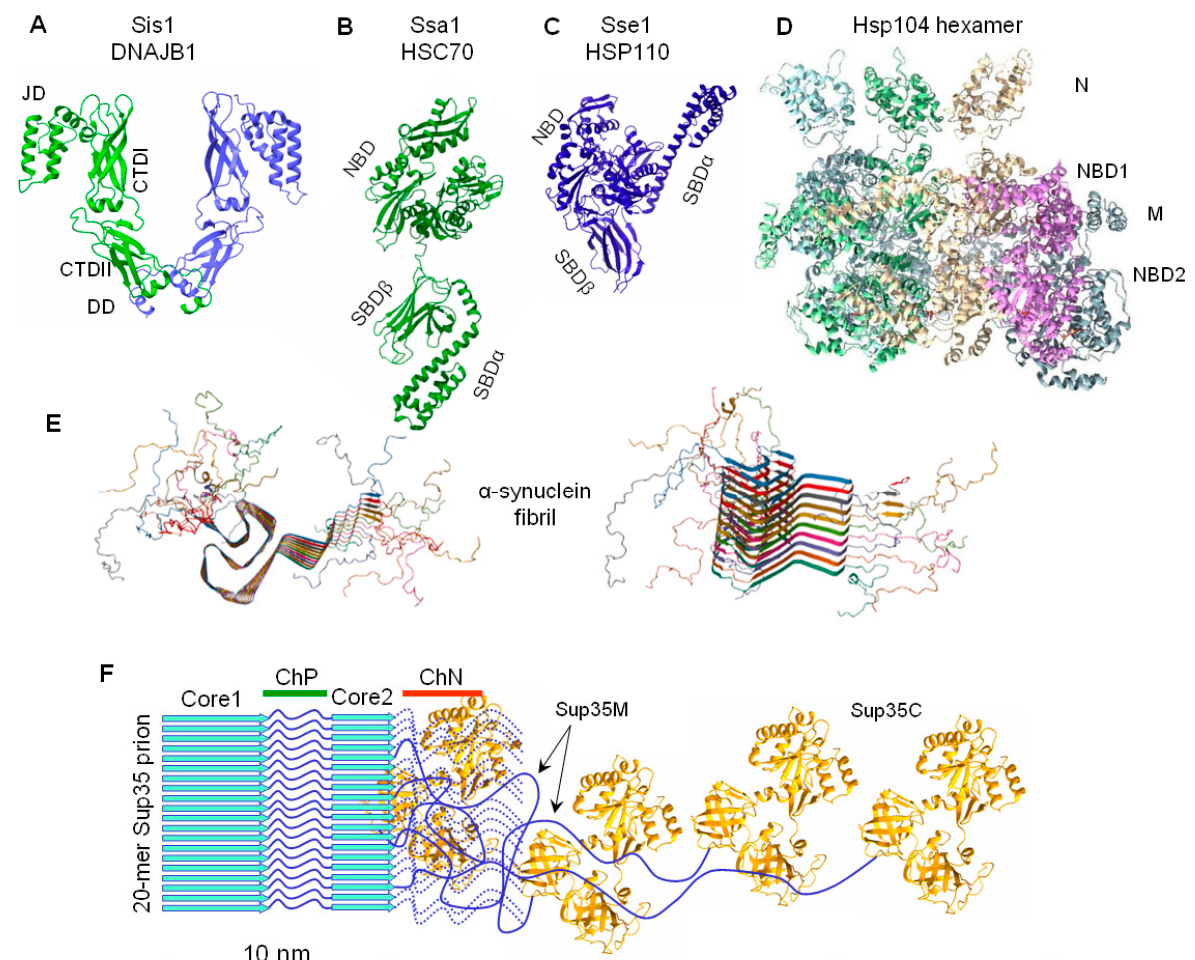
Figure 3. Relative sizes of a α -synuclein fibril, Sup35 prion, and the chaperones involved in their fragmentation. The sizes are drawn to scale. Structures of yeast chaperones are presented, while their mentioned human orthologs are of similar size and structure, such as ( A ) Sis1/DNAJB1 dimer (Sis1: PDB 6D6X+1CG3). JD: J domain; CTDI, CTDII: carboxy-terminal domains I and II; DD: dimerization domain. ( B , C ) Ssa1/Hsc70 and Sse1/HSP110 (Ssa1: PDB 2KHO, Sse1: PDB 2QXL). NBD: nucleotide binding domain; SBD α and SBD β : substrate-binding domain. ( D ) Hsp104 hexamer (PDB 5KNE). N, M: domains N and M; NBD1, NBD2: nucleotide binding domains 1 and 2. ( E ) α -syn fibril (PDB 2N0A). ( F ) Sup35 prion (Sup35C: PDB 1R5B). Sup35 prion structure with two protease-resistant cores is depicted, though in some [ PSI + ] variants Core 2 is absent and/or additional structures in the M domain are present. For clarity, only four Sup35 C domains and M domains (blue line) are shown; other copies of the M domain are indicated by dotted lines. ChP—a non-structured protease-sensitive region of the Sup35N domain, presumably used for productive binding of Hsp104 via Sis1 and Ssa chaperones. ChN—the region 129–148 of direct but non-productive Hsp104 binding. The diameter of the amyloid core, presumably corresponding to the Sup35 N domain, is about 8–10 nm [53,68]. The unfolded M domain allows the C domain to be widely offset from the fibril core, thus they form a loose halo with a diameter of 60–65 nm [68]. Notably, the M domain can acquire a folded [53] protease-resistant state, at least in a part of the prion population